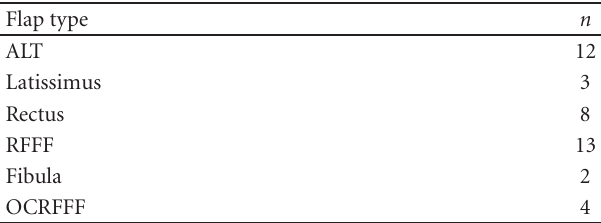
Table 2: Free flaps used for cutaneous defect reconstruction.